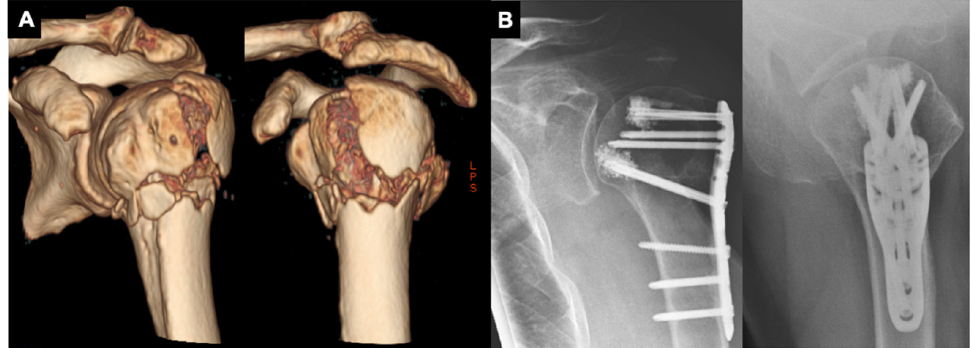
Figure 2. ( A , B ): 78-year-old male patient with a varus-impacted 3-part proximal humeral fracture treated with a PHILOS plate (DePuy Synthes ® , Umkirch, Germany) and additional humeral head screw augmentation with PMMA trauma cement.